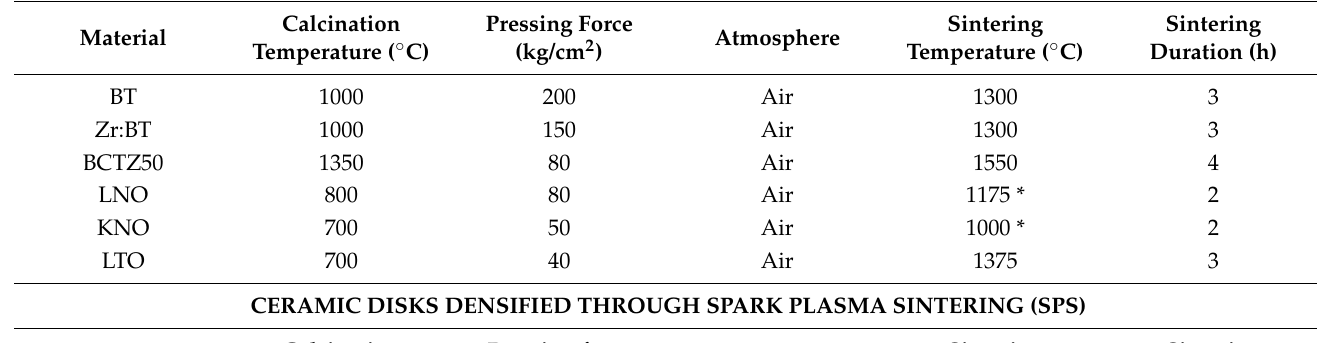
Table 1. Optimised sintering conditions for fabricating dense piezoelectric